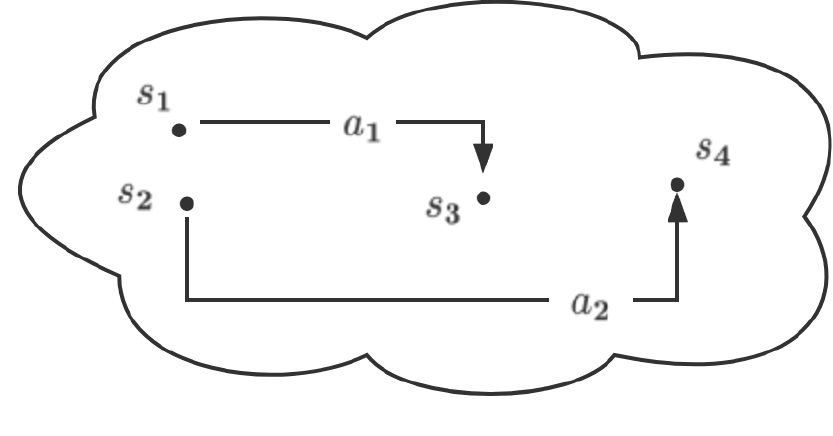
Figure 6. The choice of different actions under the same policy and different